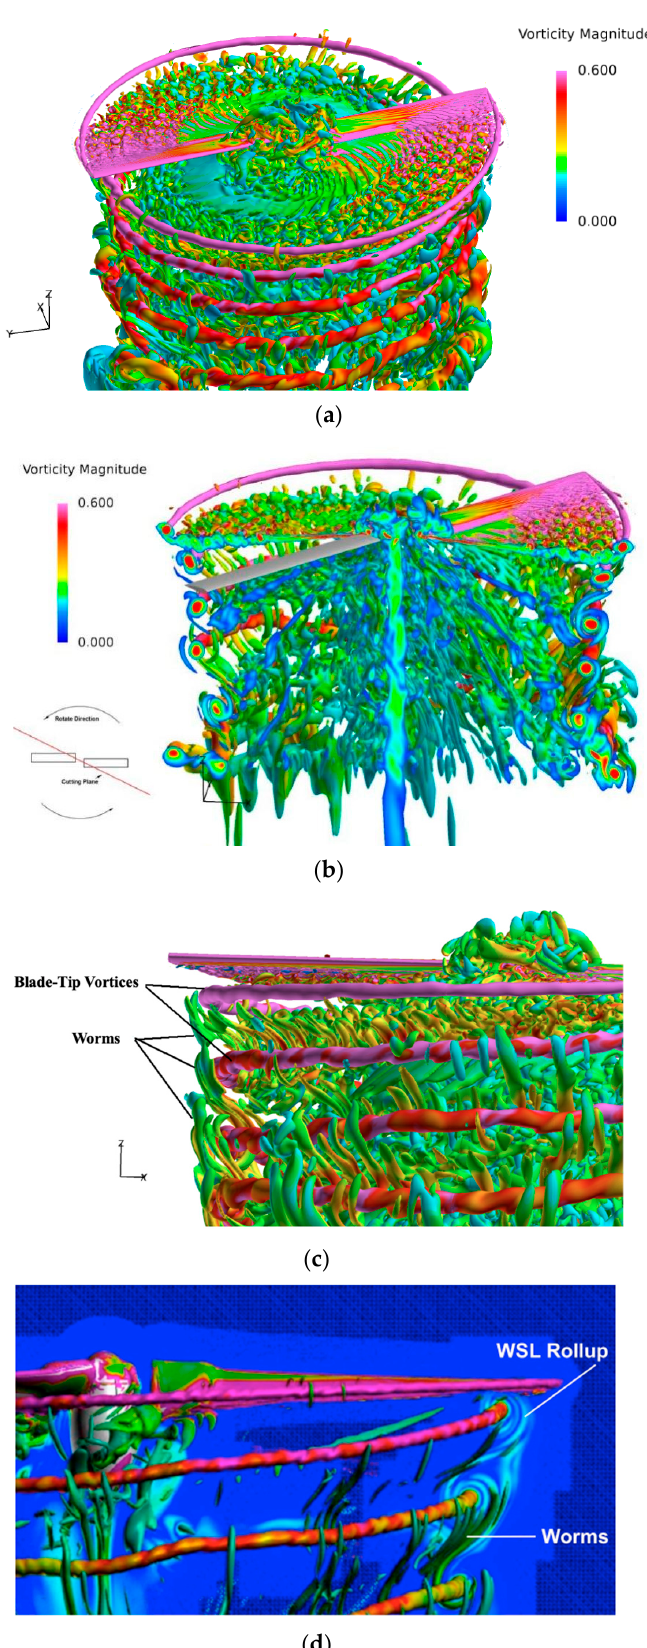
Figure 19. Blade tip vortices distribution in Q-criterion obtained by IDDES.(Q = 10.0). ( a ) Overall view, ( b ) Cutaway view, ( c ) Local enlarged view, ( d ) Worms and wake shear-layer rollup of Ref. [25].